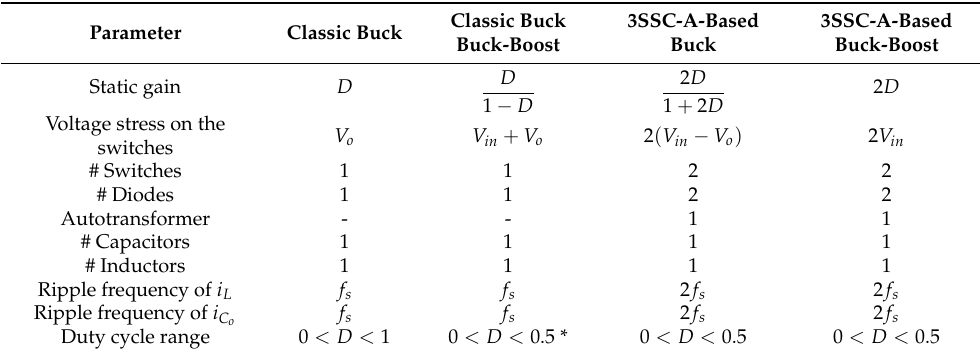
Table 6. Comparison among 3SSC-A-based step-down DC–DC converters and the classical topologies in